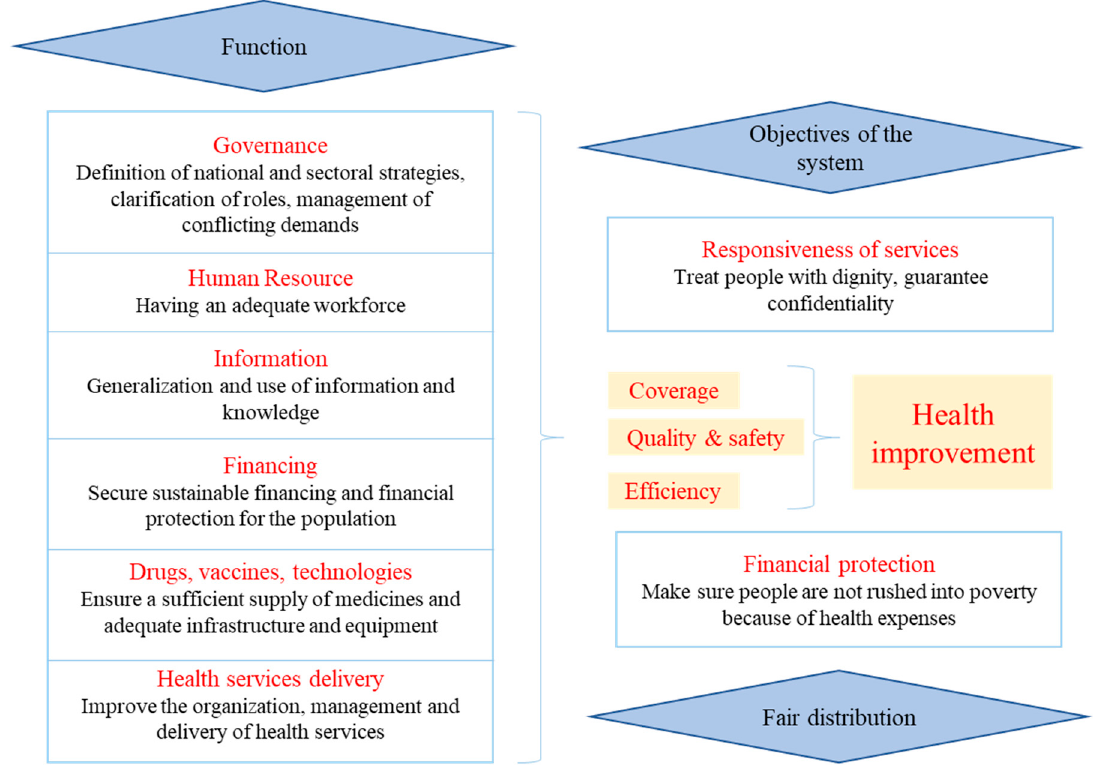
Figure 1. Health system functions according to WHO.